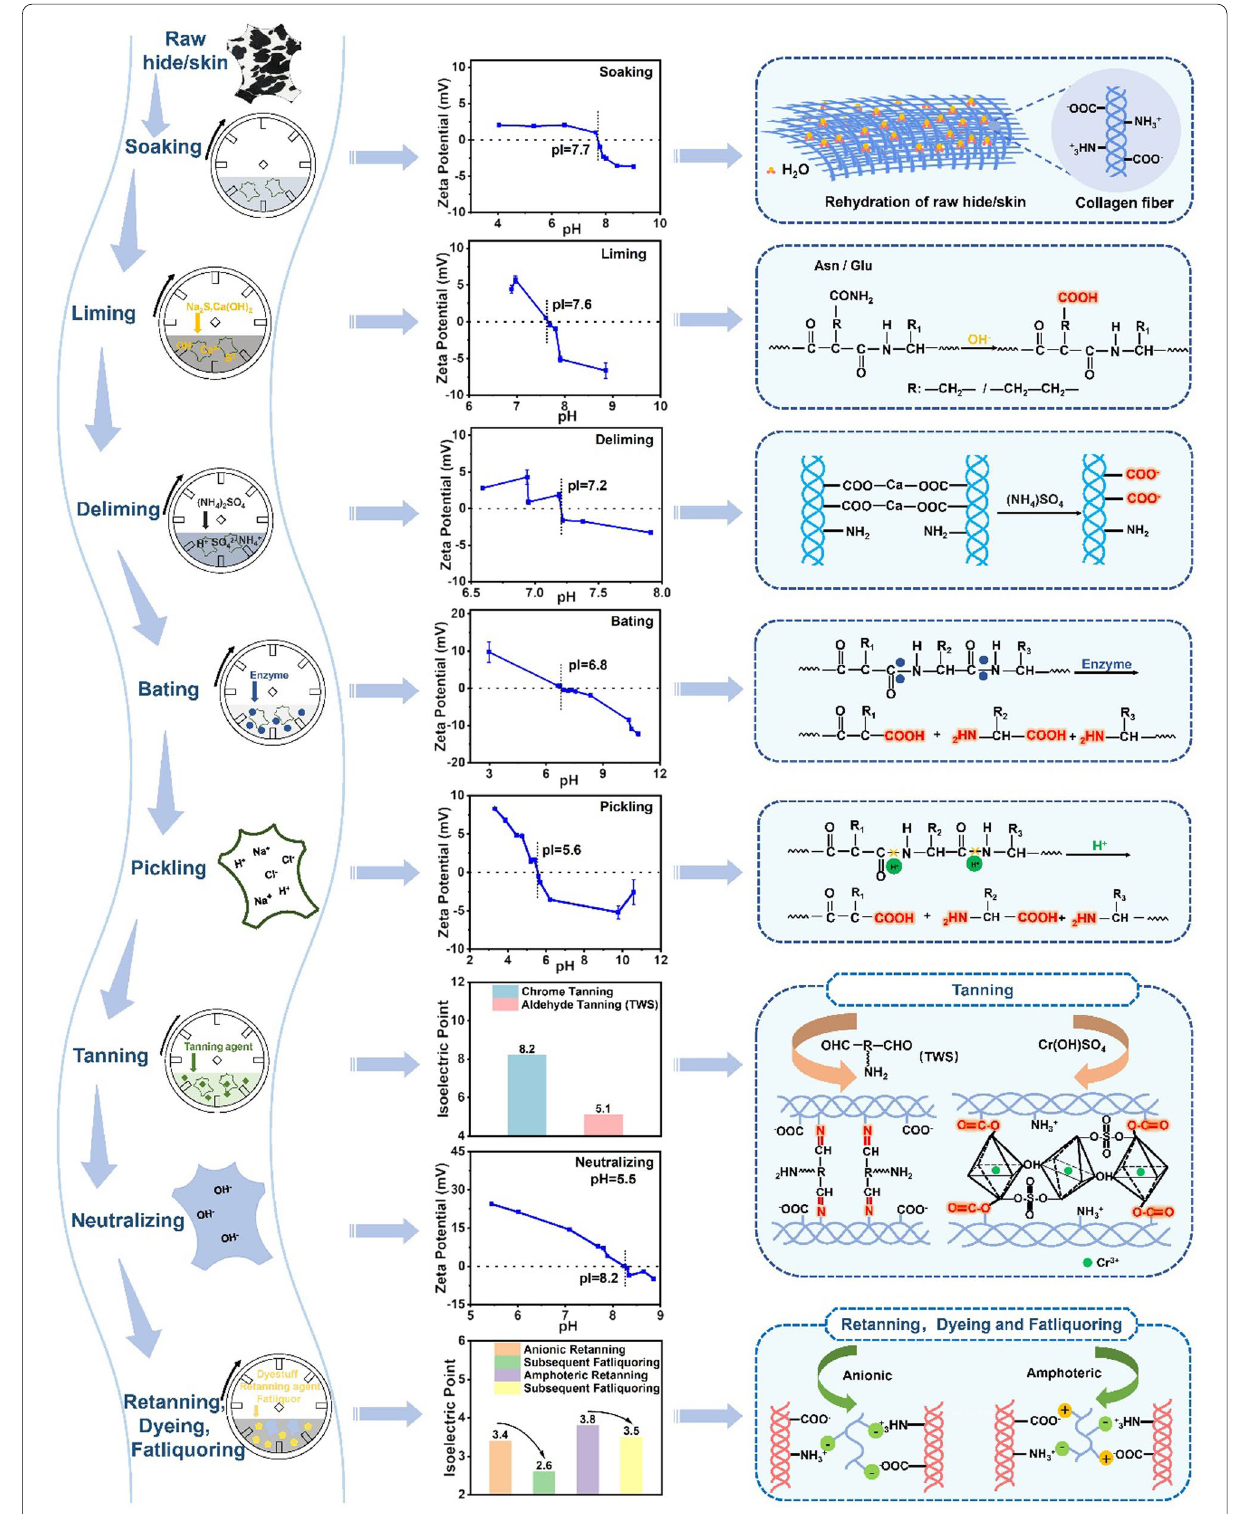
Fig. 1 Flow chart of leather processing and corresponding isoelectric points of